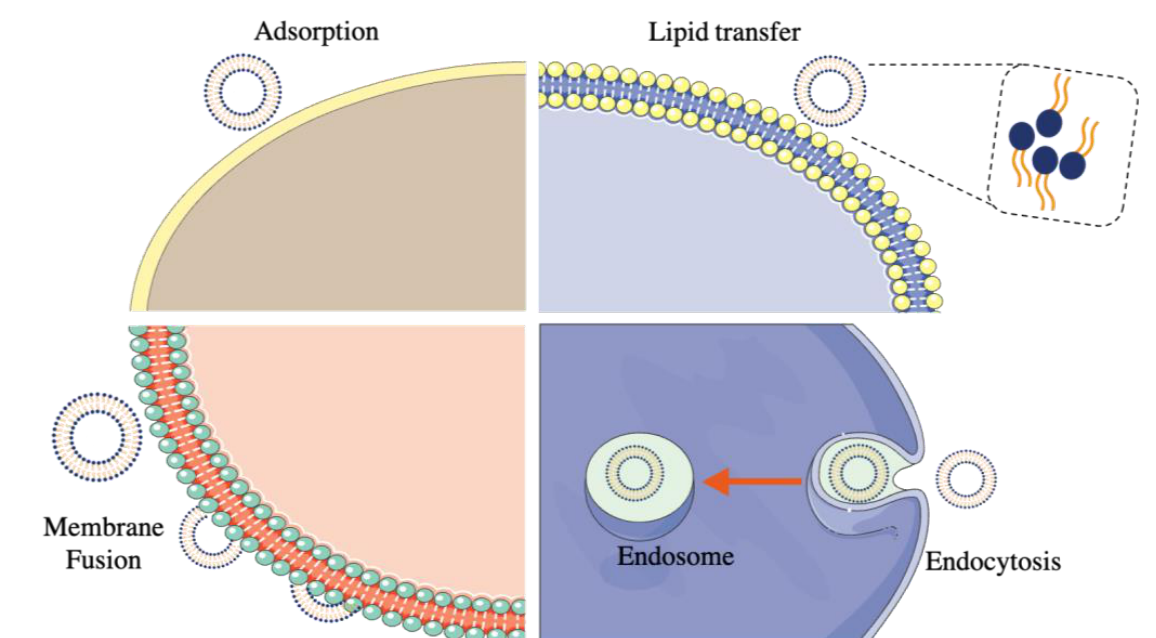
Figure 4. An illustration of the interactions between liposomes and cells.